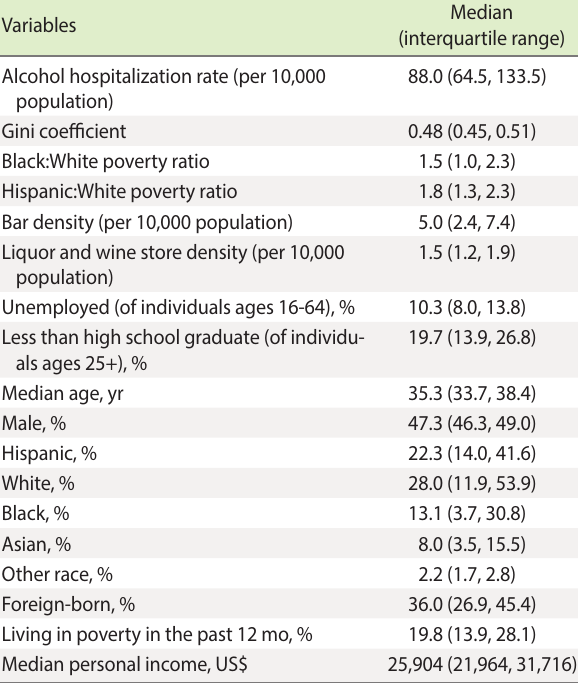
Table 1. Median and range of included NYC PUMA study variables 1